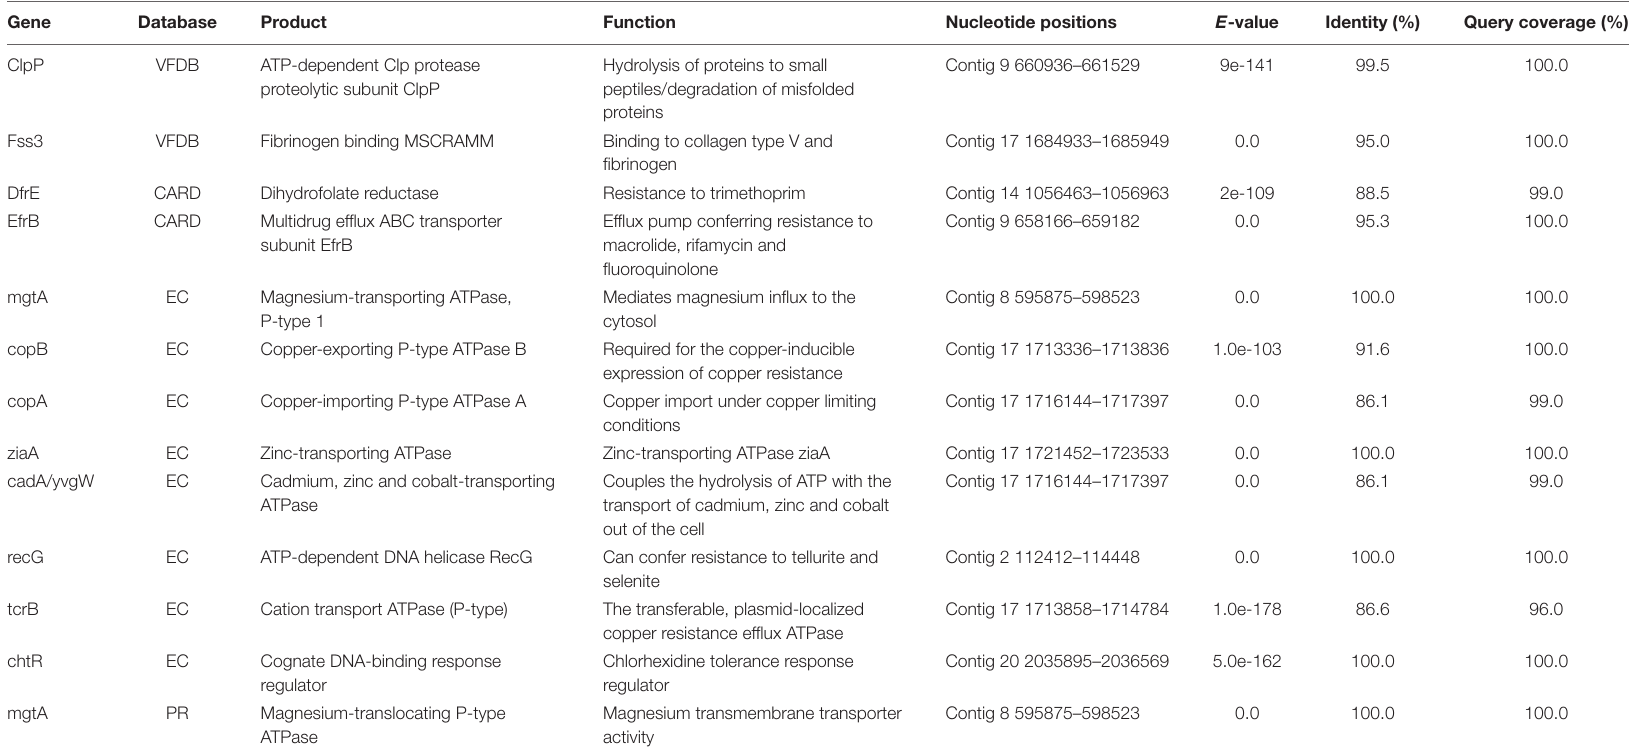
CARD, comprehensive antibiotic resistance database; EC, experimentally confirmed resistance database; VFDB, virulence factor database; PR, predicted resistance